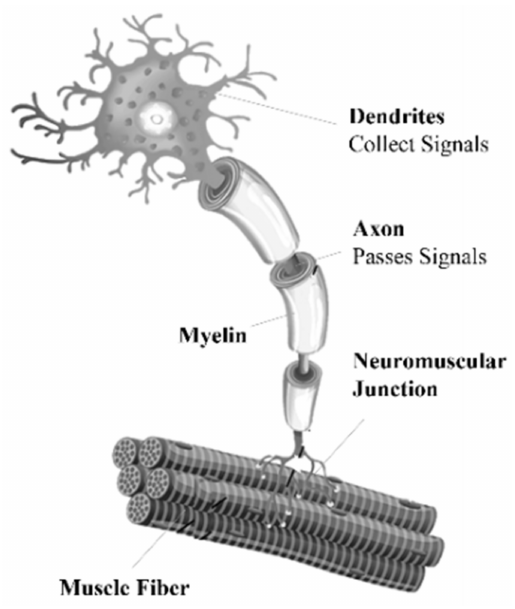
Figure 1. Components of the motor neuron, [21].